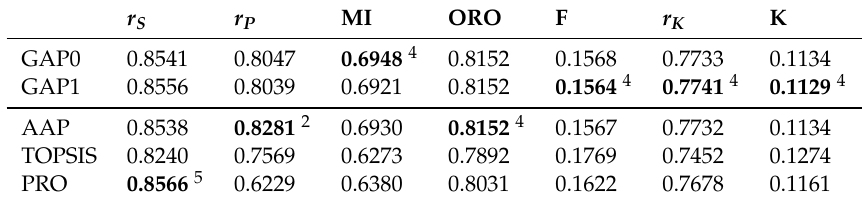
Table 5. Average similarity between the target variable (Last.fm artist plays) and the aggregation With bold, we denote the best average performance per measure of similarity (column). With the exponents, we denote the best similarity scores for which their difference from the 2nd, 3rd, 4th, or 5th best, respectively, is statistically significant (95% confidence) after Bonferroni correction for multiple